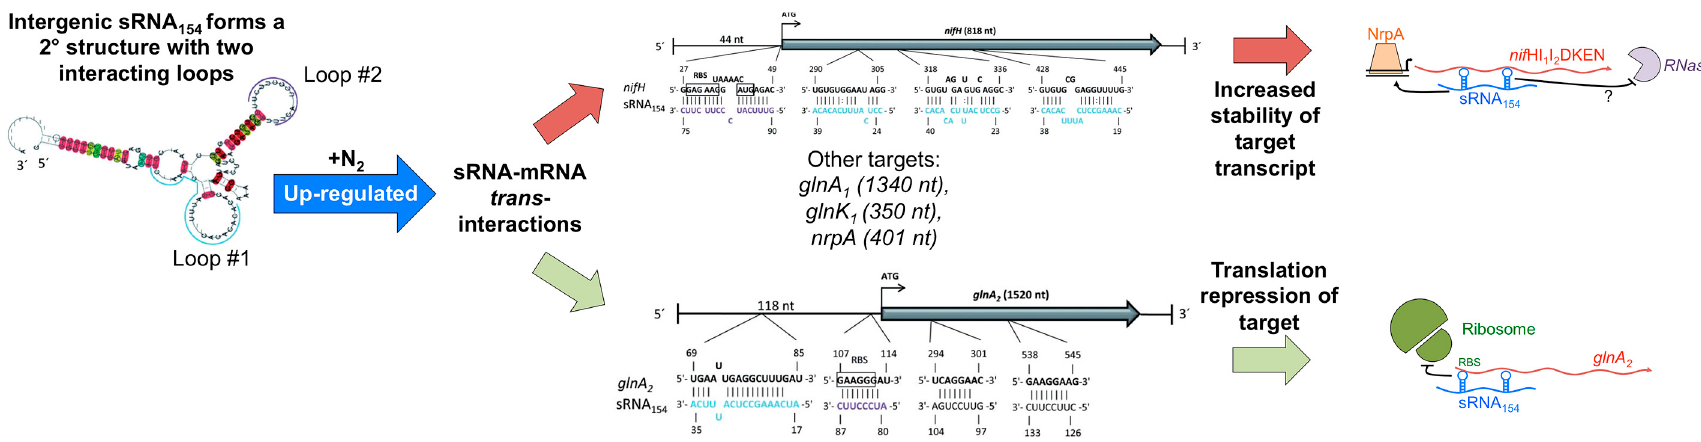
Figure 3. Two proposed mechanisms of action and targets for the intergenic sRNAs (itsRNA), sRNA 154 , in M. mazei under conditions in which N 2 is the only source of nitrogen modified from [5]. sRNA 154 is predicted to form a stable secondary structure with two stem loops that interact with mRNA targets. Mechanism 1 ( top ): target stabilization by sRNA-mediated masking of sites for degradation by an unknown RNase for the nif operon and the transcription factor nrp A, which regulate the nif operon. Mechanism 2 ( bottom ): sRNA 154 binds to the glnA 2 ribosome binding site (RBS) via loop #2, preventing translating and thus decreasing the amount of protein produced but not that of the transcript.